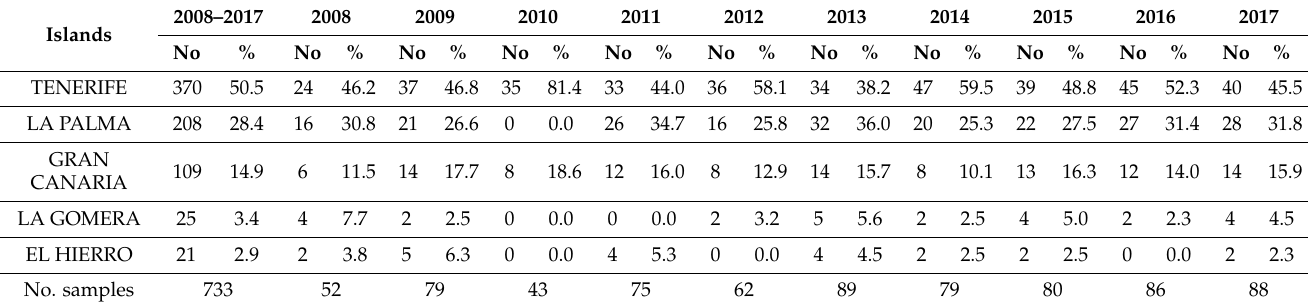
Table 1. Distribution of banana samples taken by island and year.